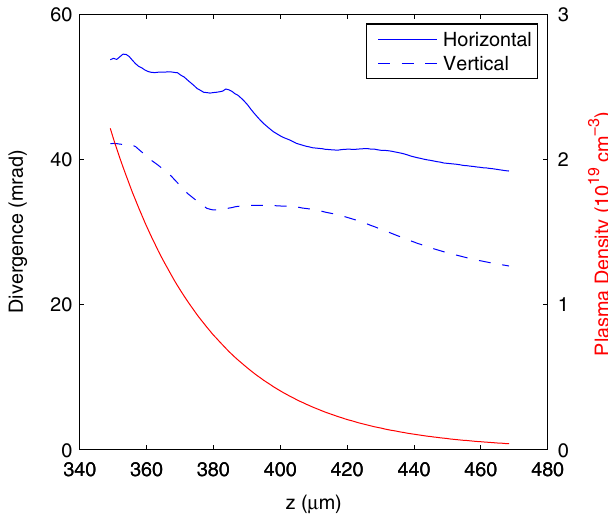
FIG. 4. Particle-in-cell simulation of the evolution of the beam angular spread at the downstream end of the plasma. Also shown is the plasma density roll-off given by an exponential function with (cid:3) ¼ 30 (cid:4) m starting at z ¼ 340 (cid:4) m .